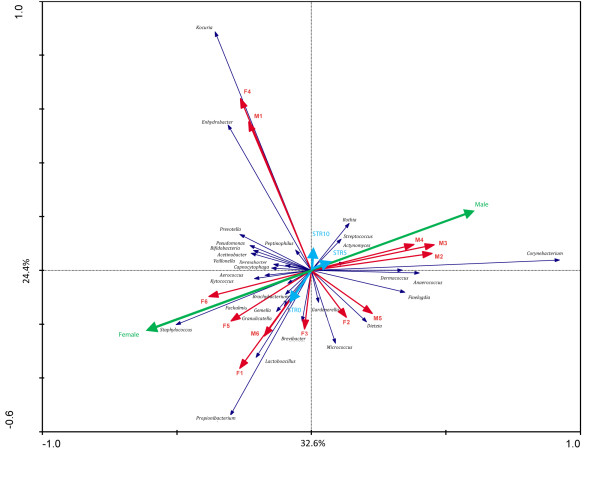
Redundancy analysis of the microbiota composition of the lower back of 12 adults for determining the most important variables (17 in total) explaining the variation in microbiota composition at the genus level. Genera that represented at least 85.1% of the first two principal components used as explanatory axis in the plots are shown as vectors. The first component and second component explain 32.6% and 24.4% of the variance, respectively. This figure was generated with Canoco version 4.5. The different variables are represented by arrows, where length reflects significance. Colors indicate sample groupings: red arrows represent all individuals, green arrows represent the males and females, and the blue arrows correspond to the stripping depth (STR0 is non-damaged healthy superficial skin, and STR5 and STR10 represent 5 and 10 times tape-stripped skin, respectively). The microbial genera are shown in black text color.